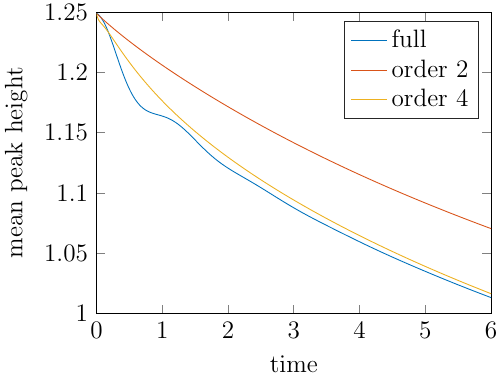
Fig. 3 Mean peak heights of Fig. 1 simulations. For times t ≳ 1 the order four simulation (Fig. 1, right) provides a good estimation of the expected mean peak height (Fig. 1, left), but the order two sim- ulation (Fig. 1, middle) decays too